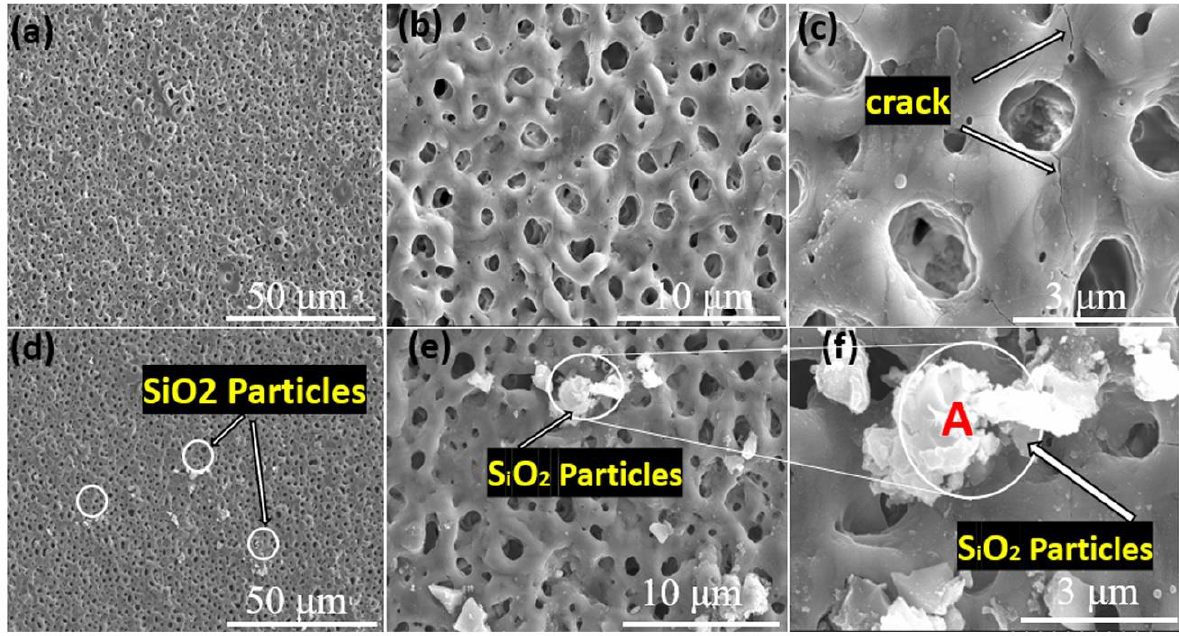
Figure 1. Surface morphologies of the titanium samples treated by PEO in different electrolytes ( a – c ) Bath A and ( d – f ) Bath B.